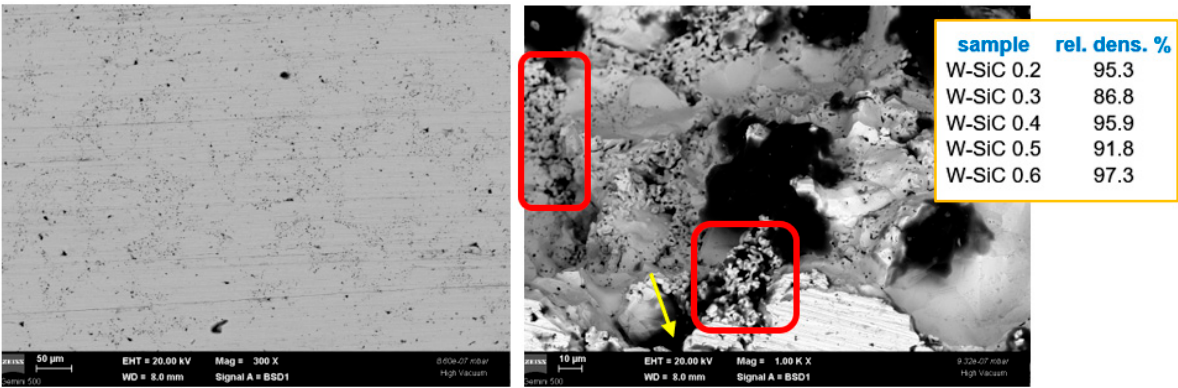
Figure 3. Cross-section SEM images obtained using a backscattered electron detector for W-SiC materials: low magnification ( left ) and higher magnification in a fractured part, also near a larger pore ( right ). Here, the areas marked in red correspond to agglomerations of smaller W grains, while the yellow arrow indicates a pore. The inset summarizes the density values of these